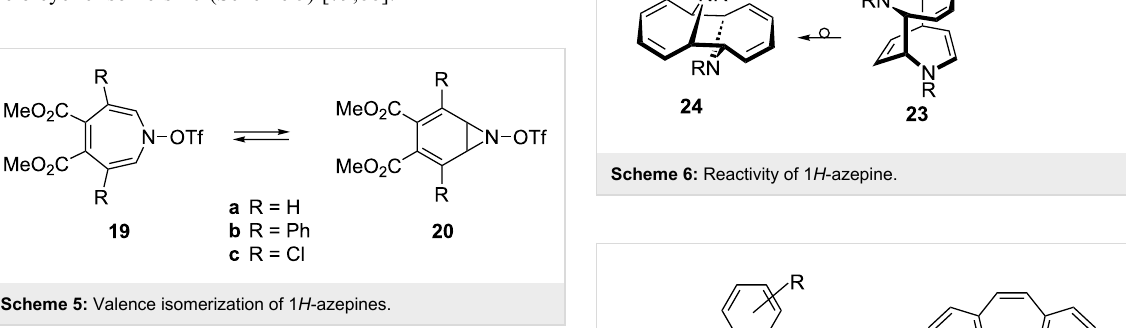
Scheme 6: Reactivity of 1 H -azepine.